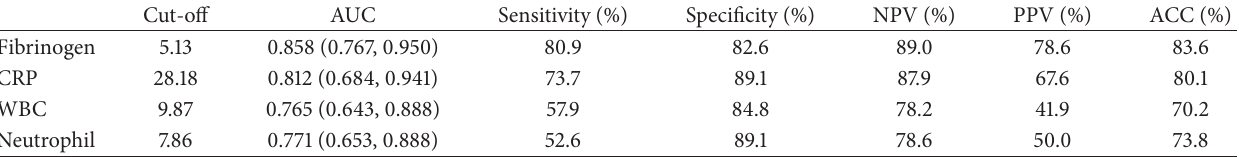
Table 4: Overall accuracy and ROC analyses of fibrinogen and other markers of inflammation to predict amputation from DFU.